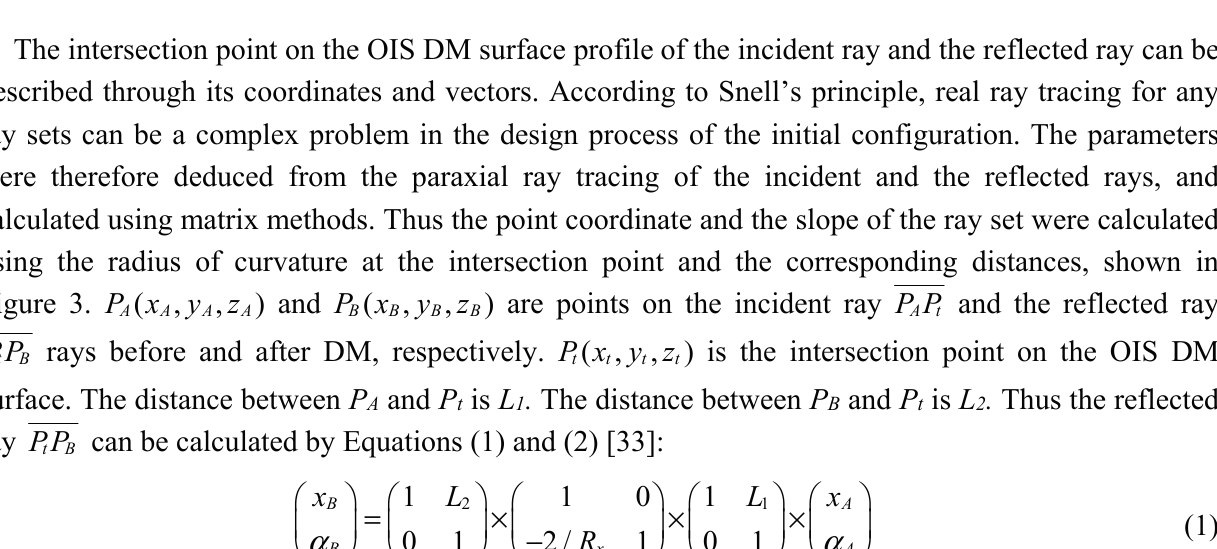
Figure 2. OIS DM segment design through the use of ray tracing in 3D